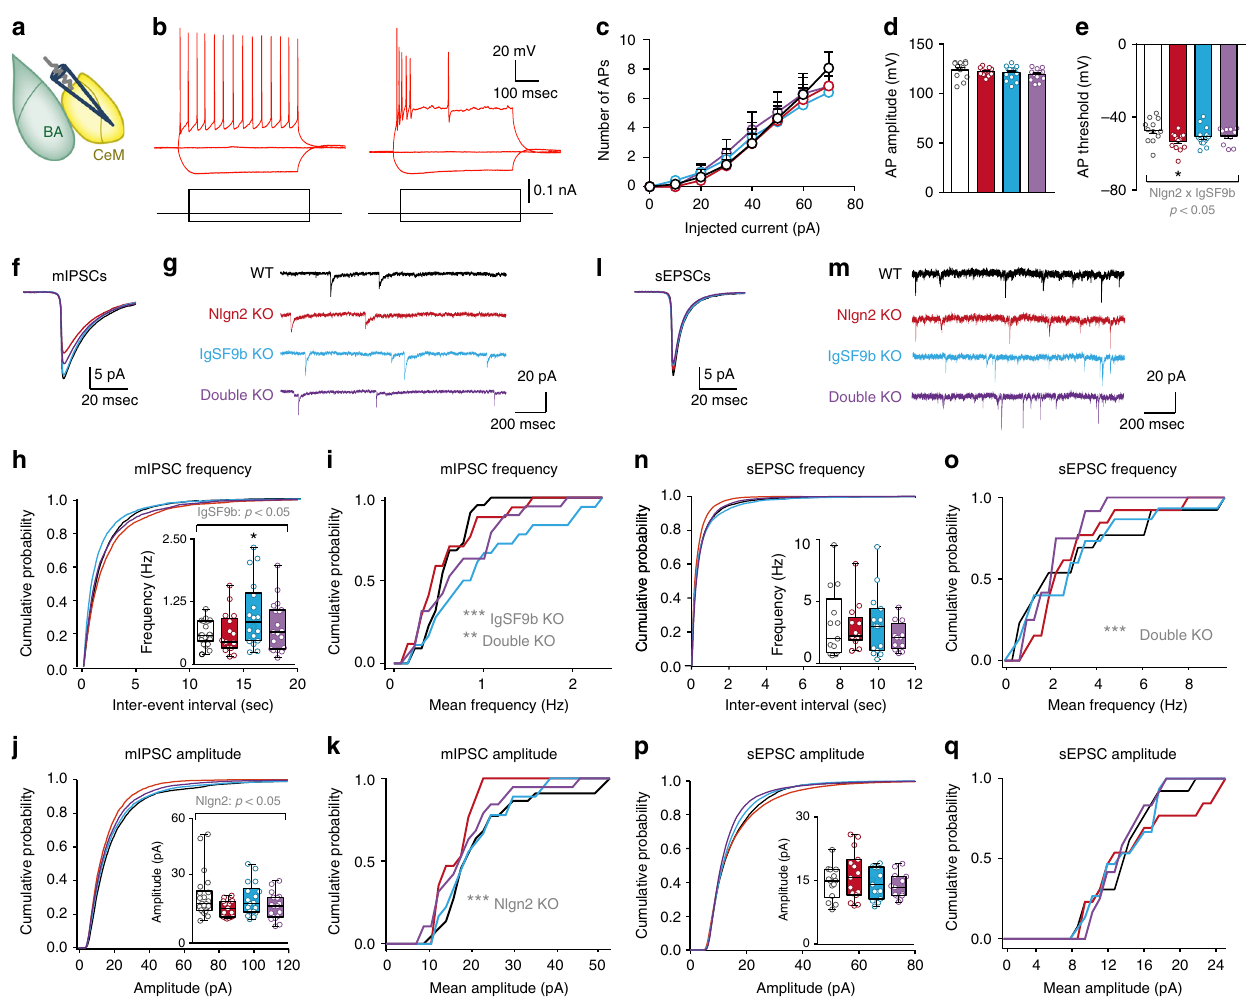
Fig. 5 IgSF9b deletion upregulates inhibitory synapse function in the CeM. a Schematic diagram showing location of mIPSC and sEPSC recordings in the CeM. b Representative fi ring patterns of CeM neurons. c – e Mean number of action potentials (APs) in response to a 500 ms current step injection ( c ), mean amplitude of the fi rst AP ( d ), and mean AP fi ring threshold ( e ) in CeM neurons of WT, Nlgn2 KO, IgSF9b KO, and double KO mice. f , g Mean mIPSCs and representative mIPSC traces. h Average cumulative distribution of mIPSC inter-event intervals and quanti fi cation of mean mIPSC frequency in the CeM. i Probability distribution of mean mIPSC frequencies among all analyzed cells in the CeM. Kolmogorov – Smirnov test: WT vs. IgSF9b KO, p < 0.0001; WT vs. Double KO, p < 0.001; Nlgn2 KO vs. IgSF9b, p < 0.0001; IgSF9b KO vs. Double KO, p < 0.01. j Average cumulative distribution of mIPSC